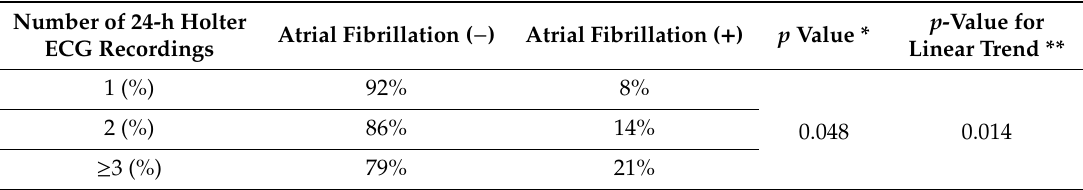
Table 3. Prevalence of atrial fibrillation detection on 24-h Holter monitoring stratified by the number of 24-h Holter-ECG